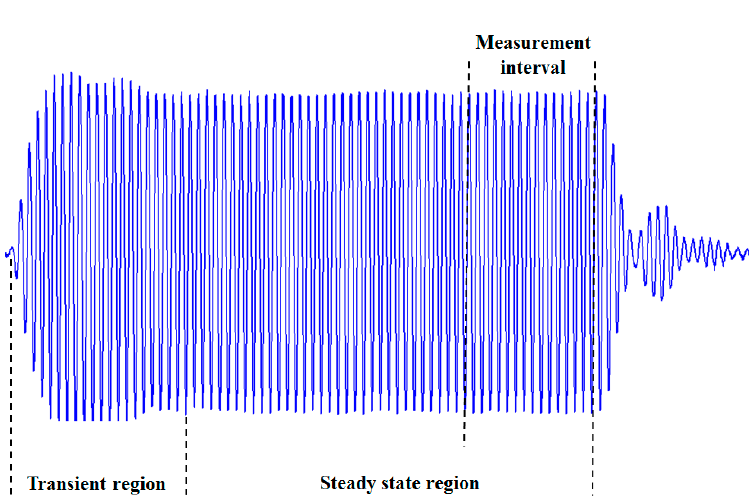
Figure 3. Response of the 4 MHz transducer to the incident ultrasonic wave.